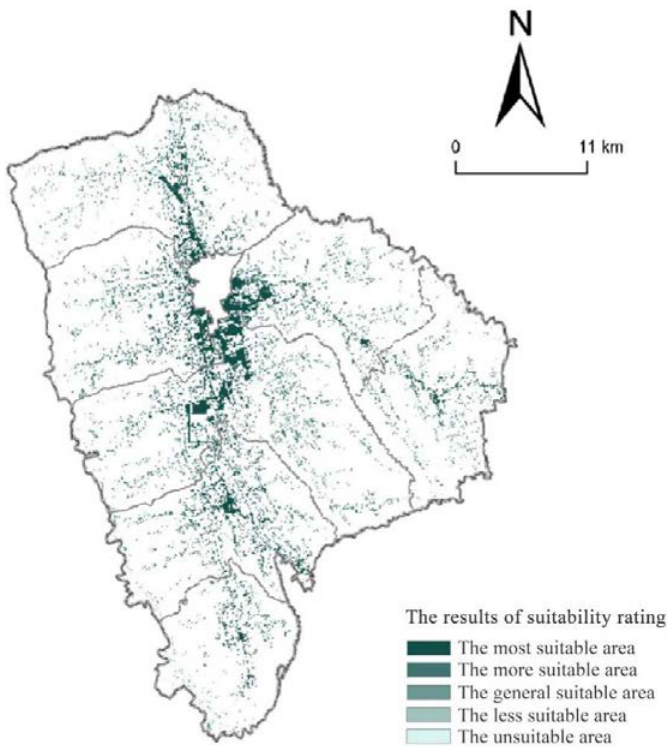
Figure 5. The suitability grade of the current construction land of townships in Xifeng.